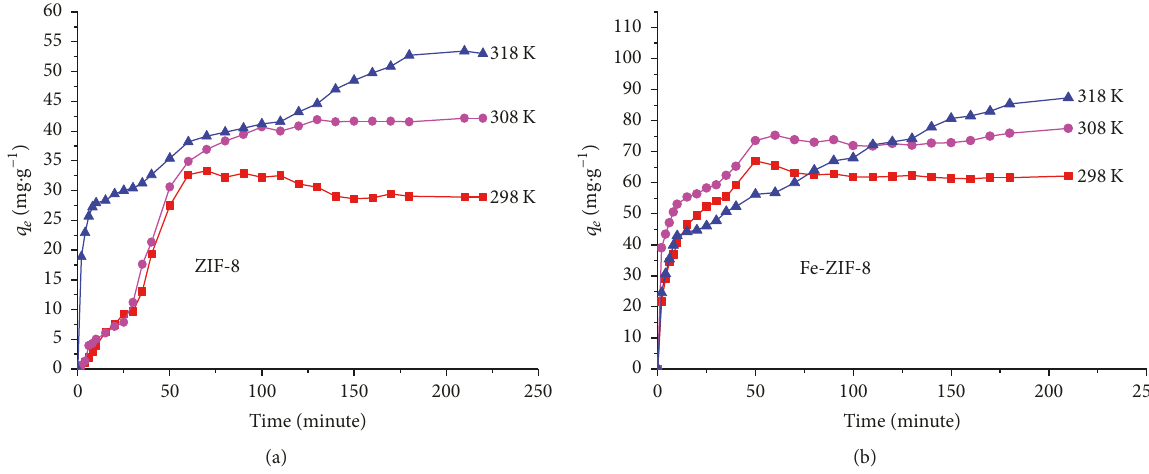
Figure 9: Effect of temperature on adsorption of RDB dye onto ZIF-8 (a) and Fe-ZIF-8 (b) ( 𝐶 500 ml, and stirring rate: 500